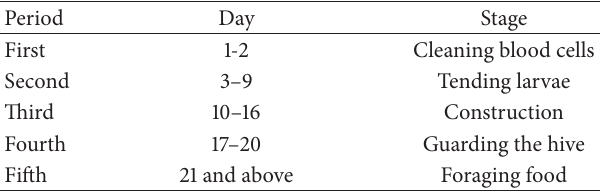
Table 2: Threshold energy of behavior mobile robot. Remaining energy Behaviors